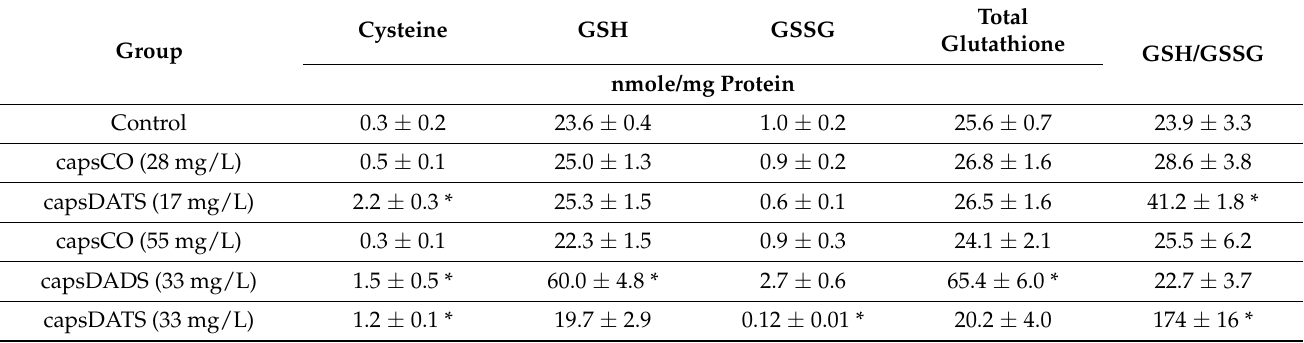
Figure 8. Representative microphotographs obtained from an optical microscope: 4T1 cells’ monolayer freshly after scratching (upper panel) and 24 h after the treatment with PBS, capsCO, capsDADS and capsDATS, respectively (lower panel). Images taken in the same sample positions. Table 2. The level of cysteine, oxidized (GSSG) and reduced (GSH) glutathione, total glutathione, and the ratio of reduced to oxidized form of glutathione in the 4T1